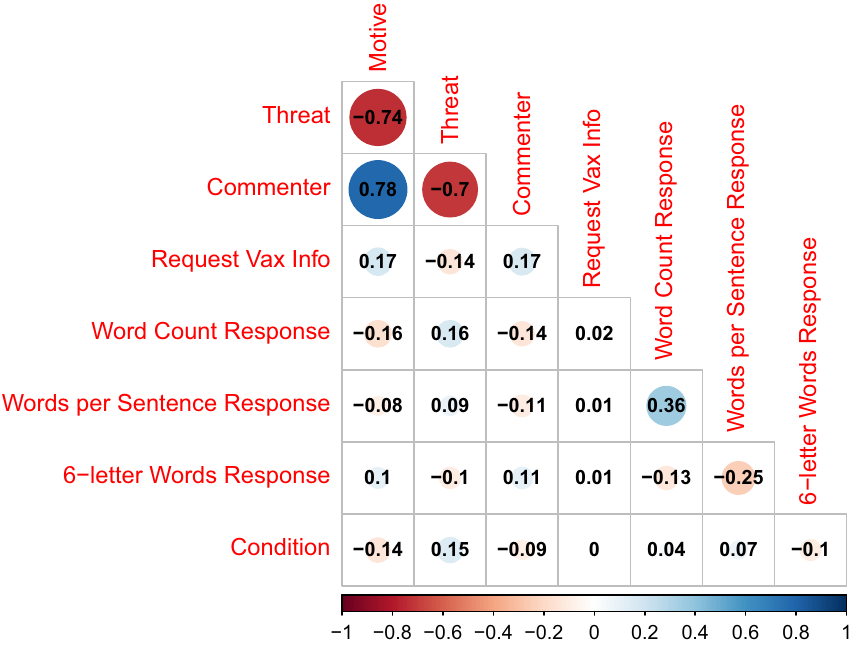
Figure 1. Correlation plot of dependent variables and condition.